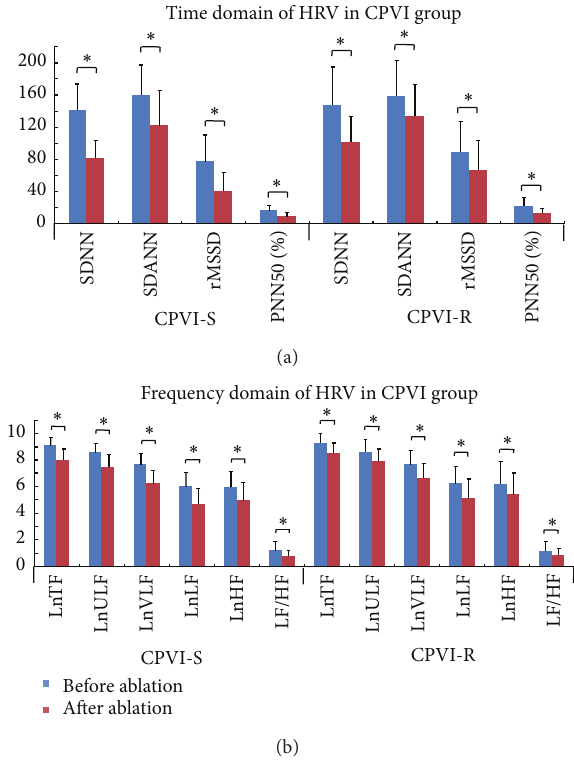
Figure 2: Comparison of HRV before and after CPVI. (a) Time- domain parameters of HRV significantly decreased after CPVI, both in the success and recurrence subgroups. (b) Frequency-domain characteristics of HRV significantly decreased after CPVI, both in the success and recurrence subgroups. Abbreviations are as in Figure 1. ∗ 𝑃 < 0.05 . that SDNN, SDANN, rMSSD, PNN50, LF, HF, and LF/HF markedly decreased after SPVI or CPVI procedures. To understand the relationship between denervation and PVI, a review of the complex network of autonomic nerves in the atrium and PVs is necessary. Through pathological examination, Armour et al. [11] identified 5 atrial ganglion- ated plexi (GP) as follows: superior right atrial GP, superior left atrial GP, posterior right atrial GP, posteromedial left atrial GP, and posterolateral left atrial GP. Similarly, by means of high-frequency stimulation, Po et al. [12] found four major left GPs as follows: superior left GP, anterior right GP, inferior left GP and inferior right GP. Vaitkevicius et al. [13] examined the intrinsic neural structures of 35 intact LA- PV complexes stained transmurally for acetylcholinesterase using a stereomicroscope. Abundant extensions of epicardial nerves penetrate the PV walls transmurally and form the subendothelial neural network beneath the roots of 4 PVs. All parasympathetic nerves ultimately synapse on GP, whereas sympathetic fibers may directly innervate the myocardium or synapse on intrinsic cardiac ganglia [14]. Tan et al. [15] reported that adrenergic and cholinergic nerves both have higher densities in the LA region within 5 mm of the PV- LA junction than in regions further ( > 5 mm) away from the junction or in the